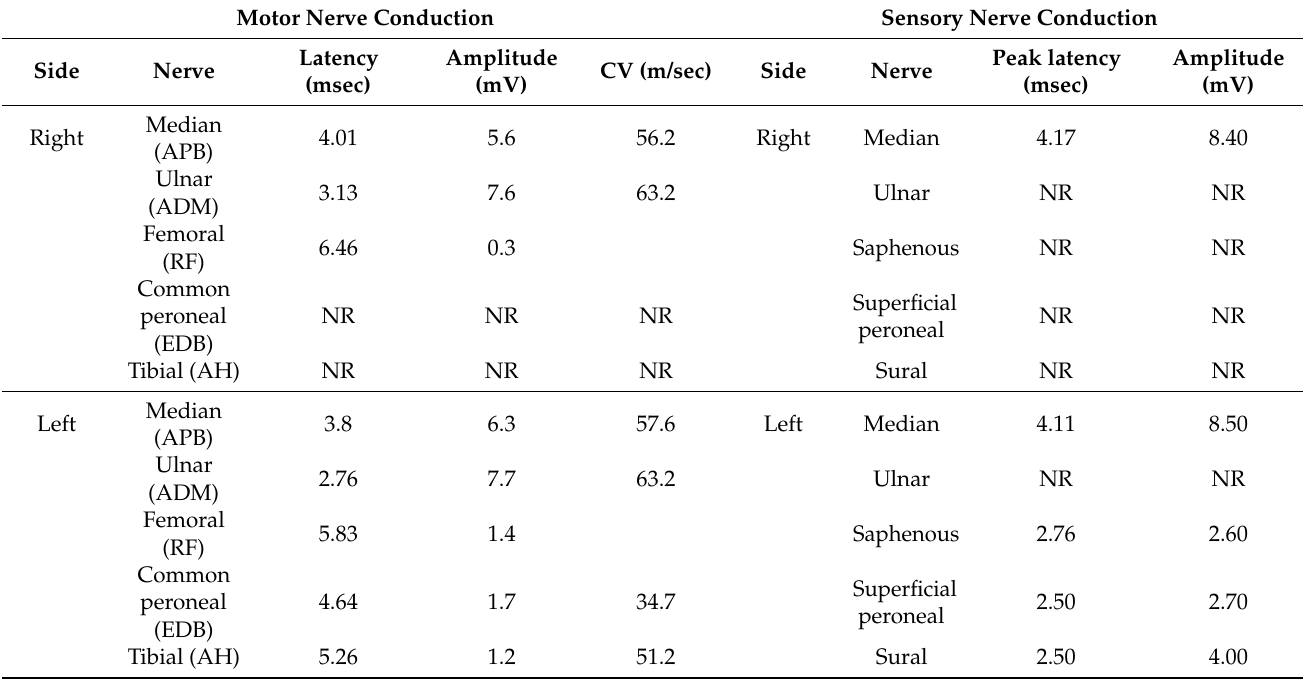
Table 1. Result of nerve conduction